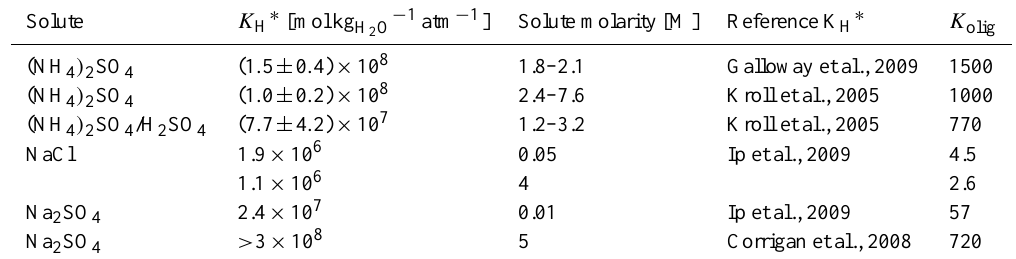
Table 3. Effective Henry’s law constants derived in experimental studies. Note that all constants are converted to a molal basis − 1 atm − 1 ] and, thus, differ from the constants in the original literature. The dimensionless oligomerization constant K [molkg H 2 O has been derived based on Eq. (5) (Sect.